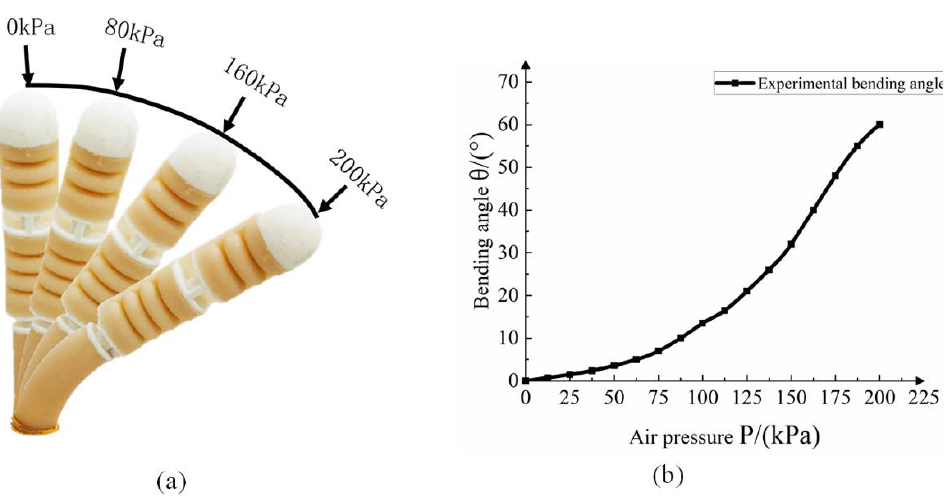
Figure 17. Bending performance of proximal phalangeal joint: ( a ) different air pressure finger bending angle, ( b ) test bending angle curve.